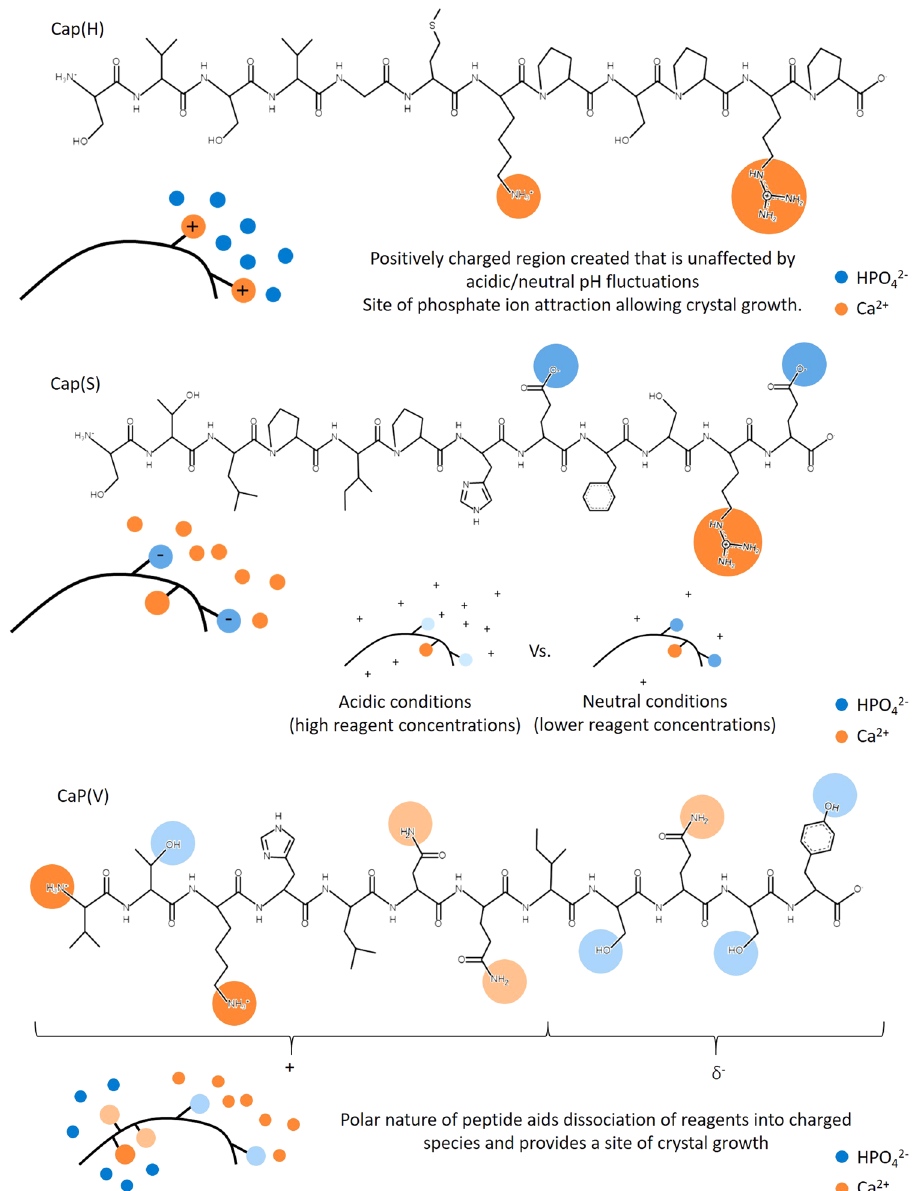
Figure 6. Influences of each peptide over mineralisation with respect to charged species and